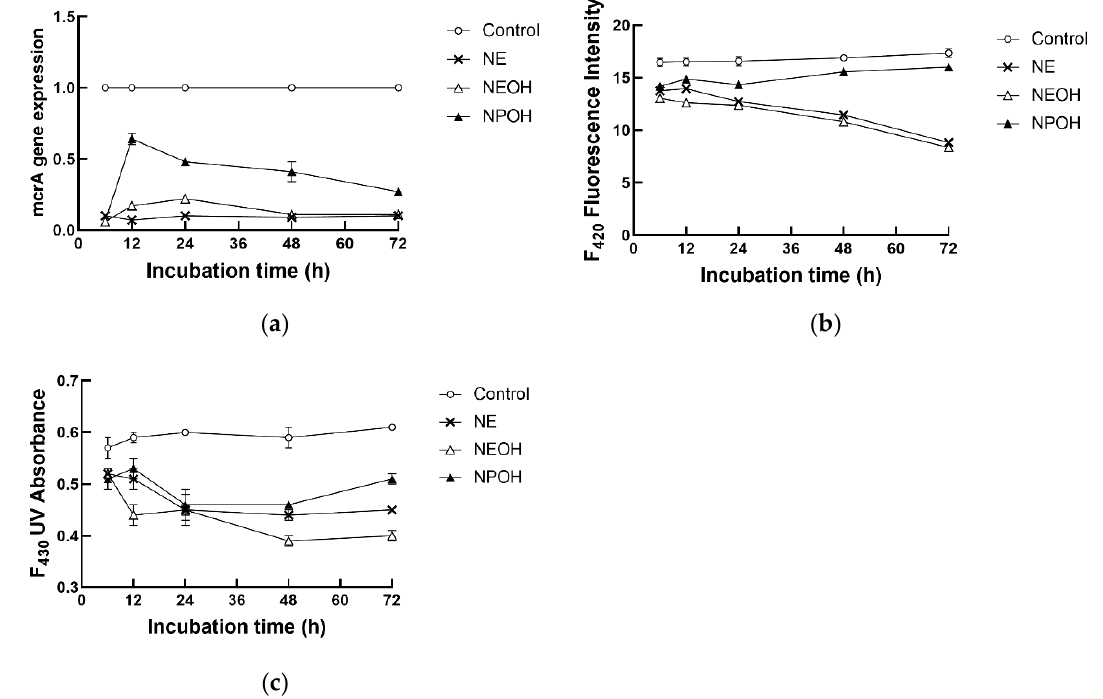
Figure 3. E ff ect of NE, NEOH, and NPOH addition to culture fluids on mcr A gene expression ( a ) and the contents of coenzyme F 420 ( b ) and coenzyme F 430 ( c ) of grain-rich feed incubated with rumen fluids obtained from lactating dairy cows. NE: nitroethane; NEOH: 2-nitroalcohol; NPOH: 2-nitro-1-propanol. Statistical analyses showed that the e ff ects of nitrocompounds were significant at p <